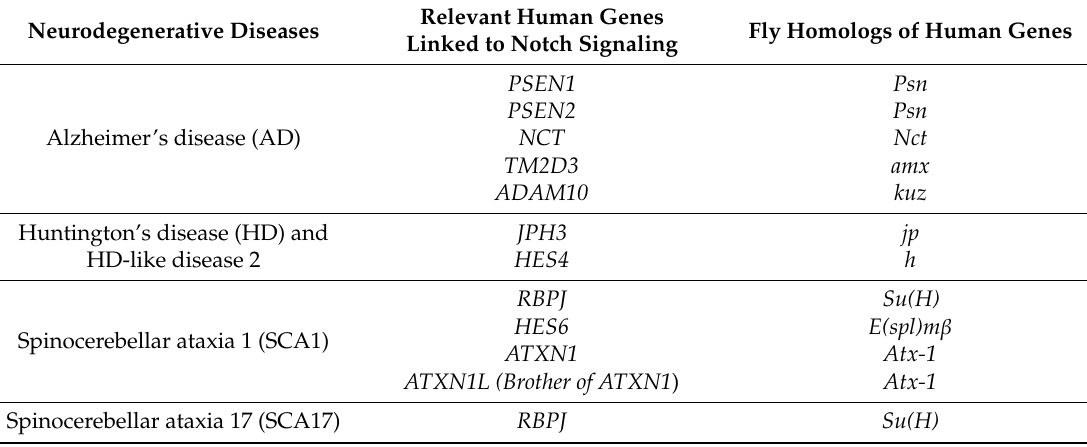
Table 3. Notch-related genes studied in the context of neurodegenerative